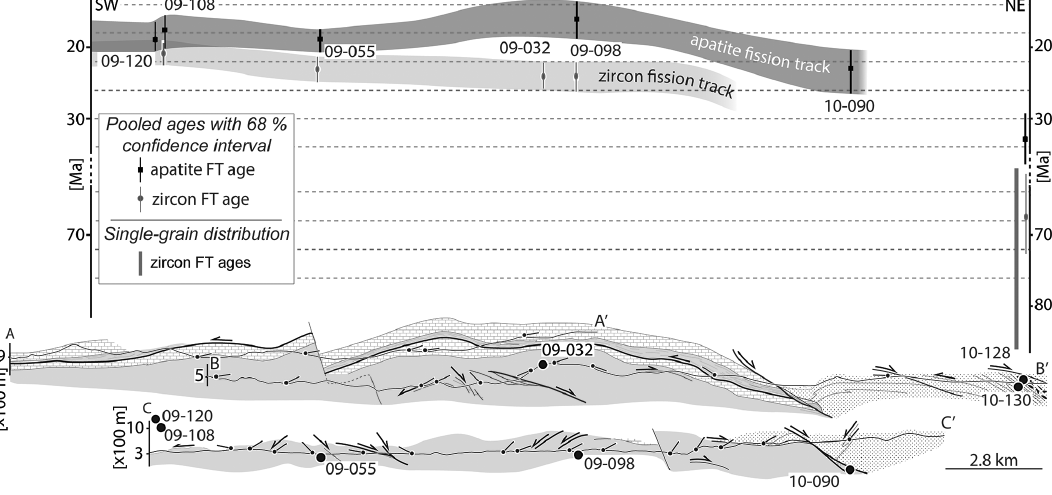
ZHe in southern Pelagonia yields 53–36 Ma ages to the west and 30–20 Ma close to and within the Olympos window (Coutand et al., 2014). To the south of the Olympos window ZHe ages are as young as 12 Ma. ZHe ages are not plotted